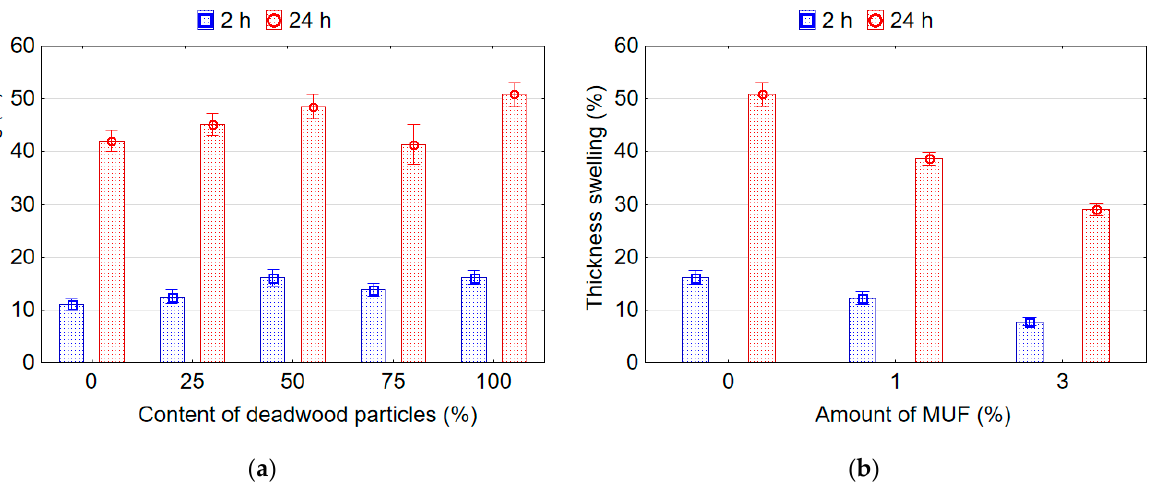
Figure 5. Thickness swelling of boards samples depending on content of deadwood particles ( a ) and amount of MUF resin in adhesive ( b ).